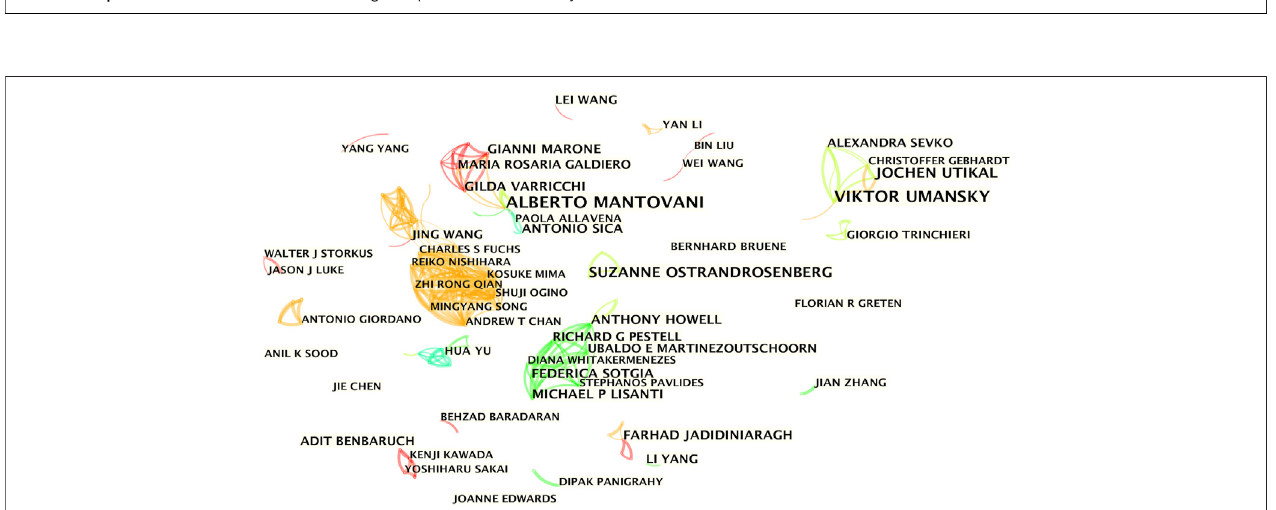
FIGURE 3 | Institution co-occurrence knowledge map of the in fl ammatory tumor microenvironment.